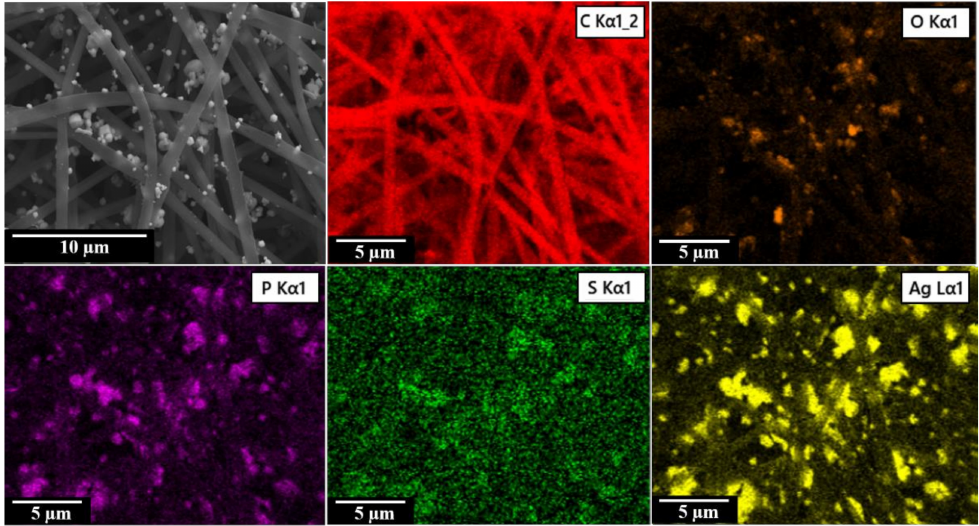
Figure 3. Elemental mapping of S-AP / PAN.